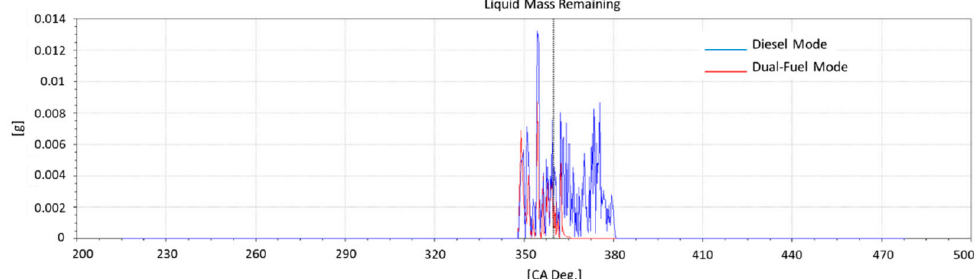
Figure 11. The liquid diesel mass remaining in the engine